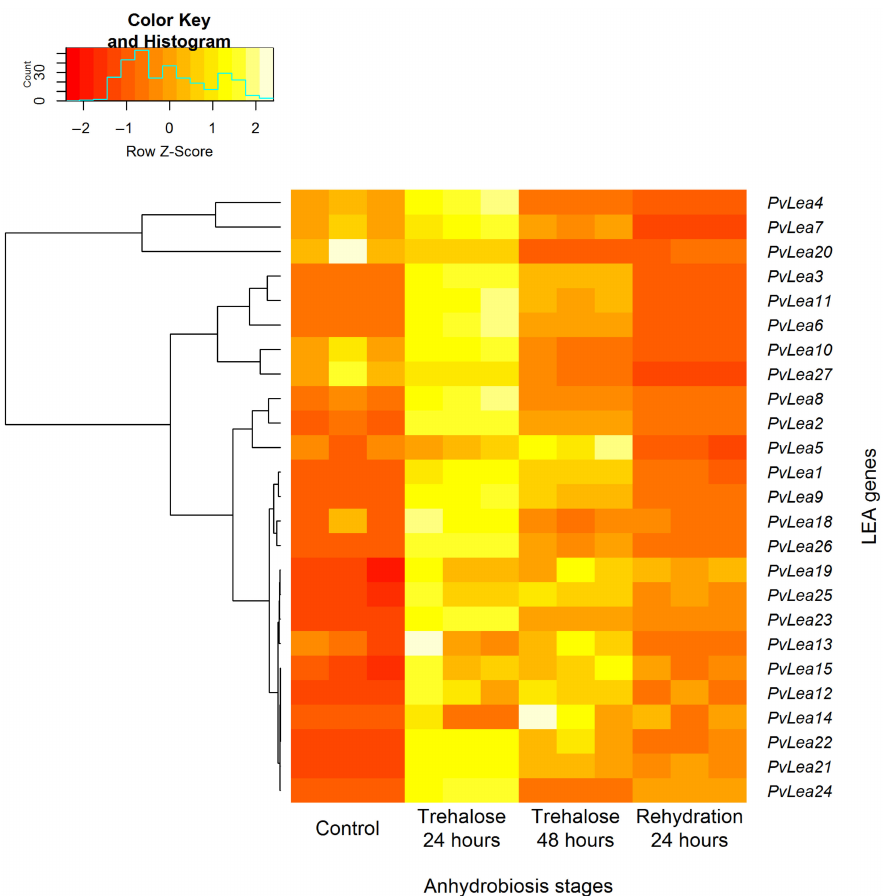
Figure 2. Heat map of PvLea genes’ expression in Pv11 cells in control conditions and at different stages of anhydrobiosis induction caused by trehalose treatment. Experimental conditions are indicated at the bottom. Normalized expression values (reads per kilobase of exon per million mapped sequence reads, RPKM) were rescaled for each gene. The resulting values of relative expression for each gene are depicted as rows, with gene names indicated on the right. Color coding of relative expression is at the top of the image, with the brightest and darkest colors reflecting the highest and lowest expression for a given gene, respectively. The brackets on the left show the clusters identified based on the similarity of relative expression